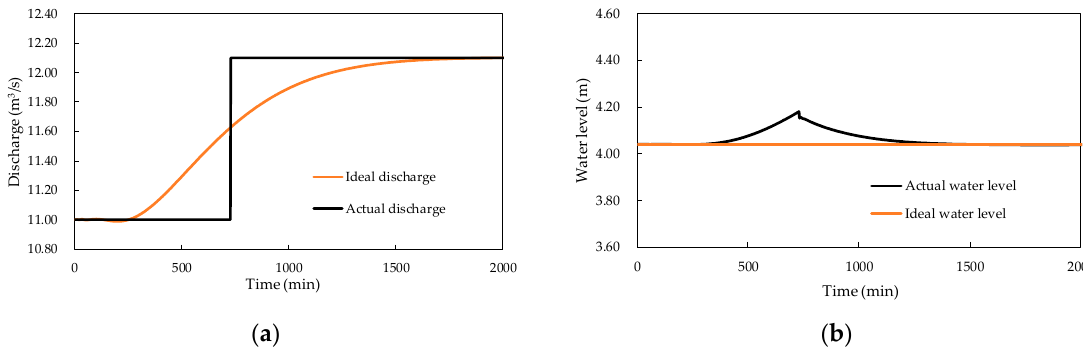
Figure 6. The variation of the discharge of the pumping station ( a ) and water level immediately upstream of the pumping station ( b ).